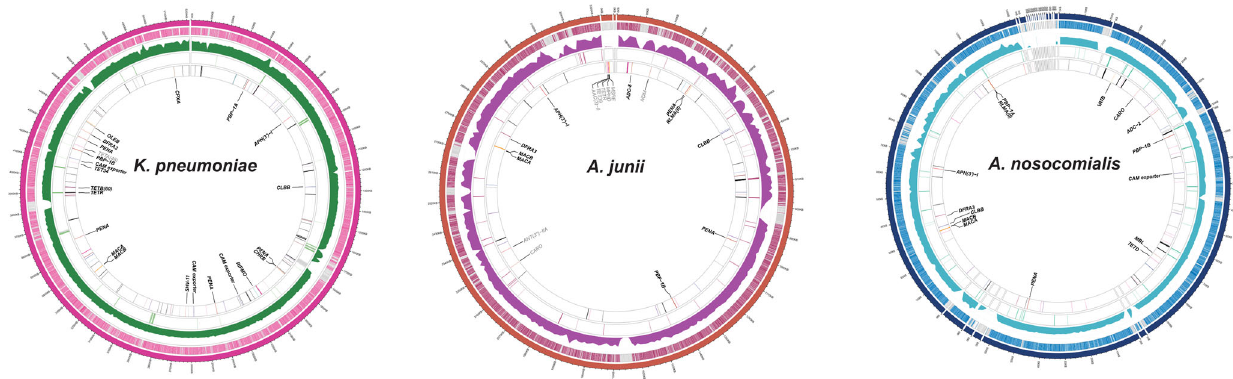
Fig. 1 Pangenome analysis of St.LI reads mapping to the nearest reference genomes for K. pneumoniae , A. junii , and A. nosocomialis . The outermost ring shows genome coverage for each pathogen. Ring two shows gene presence (color) and absence (gray). Ring three shows the depth of coverage across the reference genome in 1 kb windows. Ring four shows resistance gene locations with presence (color) and absence (gray). Ring fi ve shows antibiotic resistance genes by type (gray labels are absent) with select